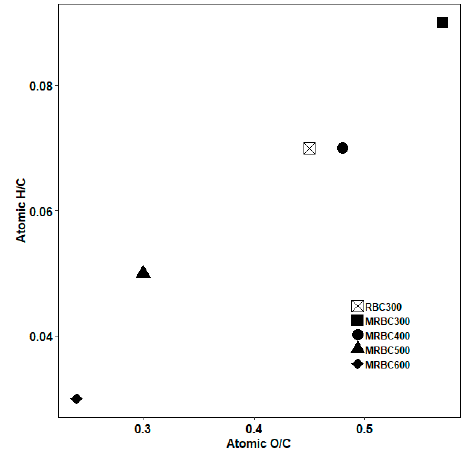
Figure 7. The Van Krevelen plot of elemental ratios for biochars produced at different pyrolytic temperatures.